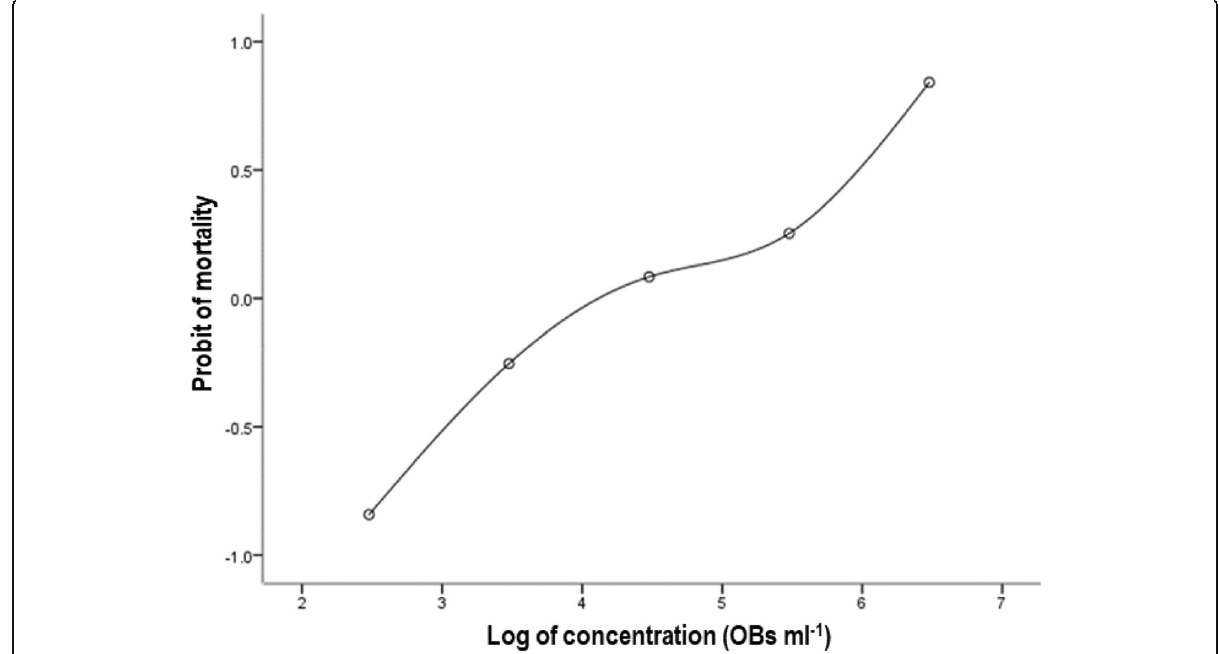
Fig. 2 Log (conc.)-probit mortality curve for Helicoverpa armigera larvae at different occlusion body (OB) concentrations